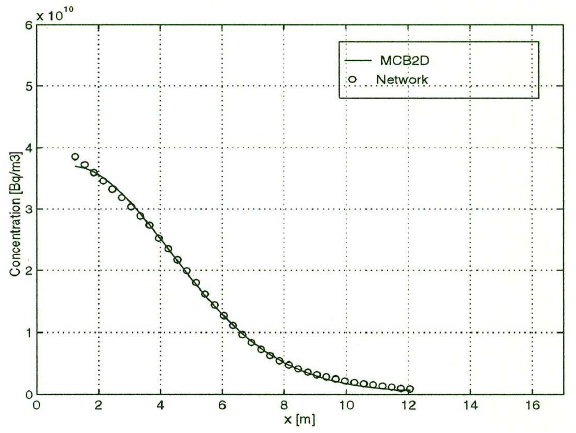
Fig. 4.5. Network 1, v/R=5.6 (cid:215) 10 -4 m/d, e test=0.4%